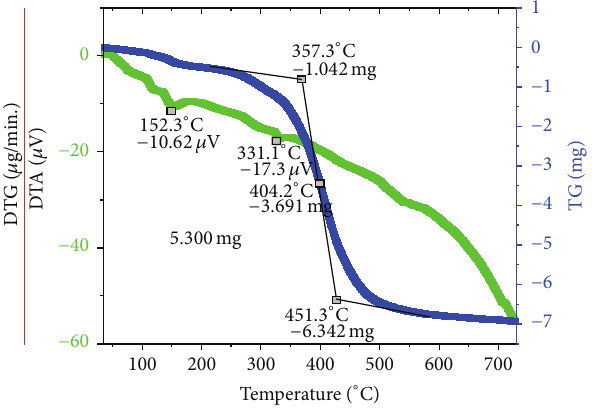
Figure 6: DTA of sample